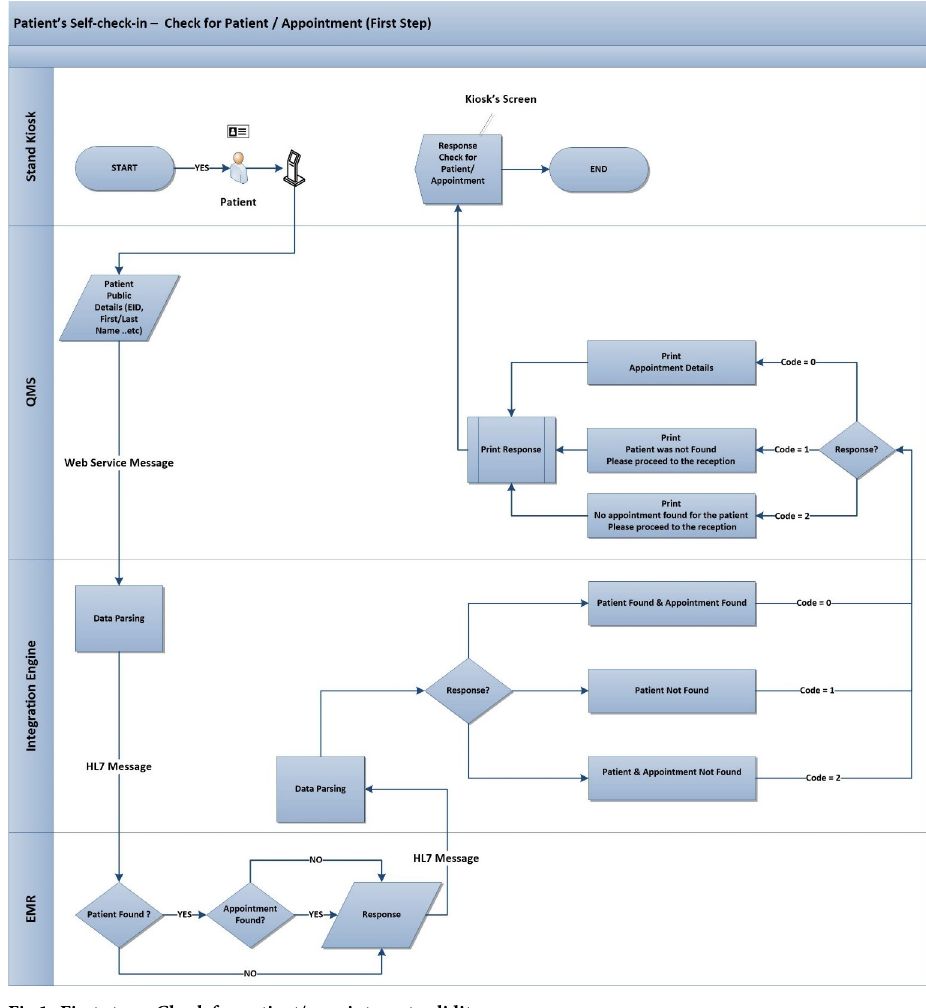
Fig 1. First step—Check for patient/appointment